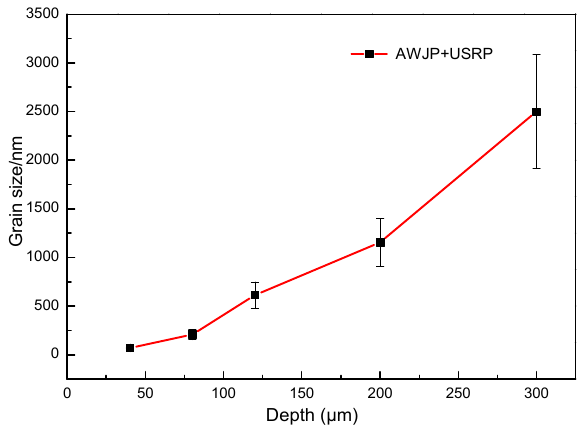
Figure 11. Comparison of grain size along the thickness direction.